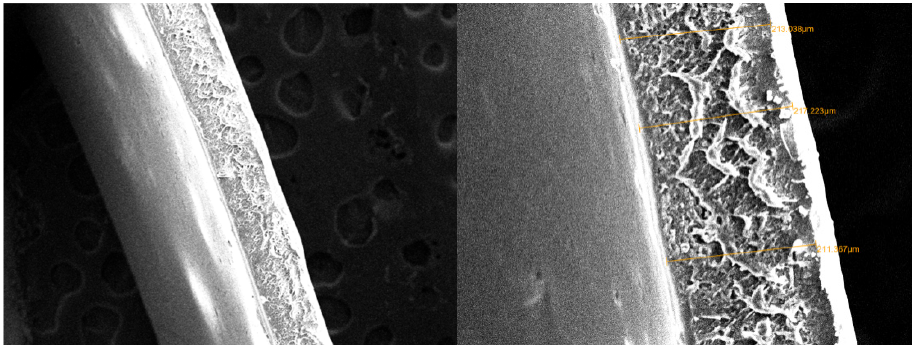
Figure 4. Cross-section of PUM-RSB with a magnification of 60 and 200× .